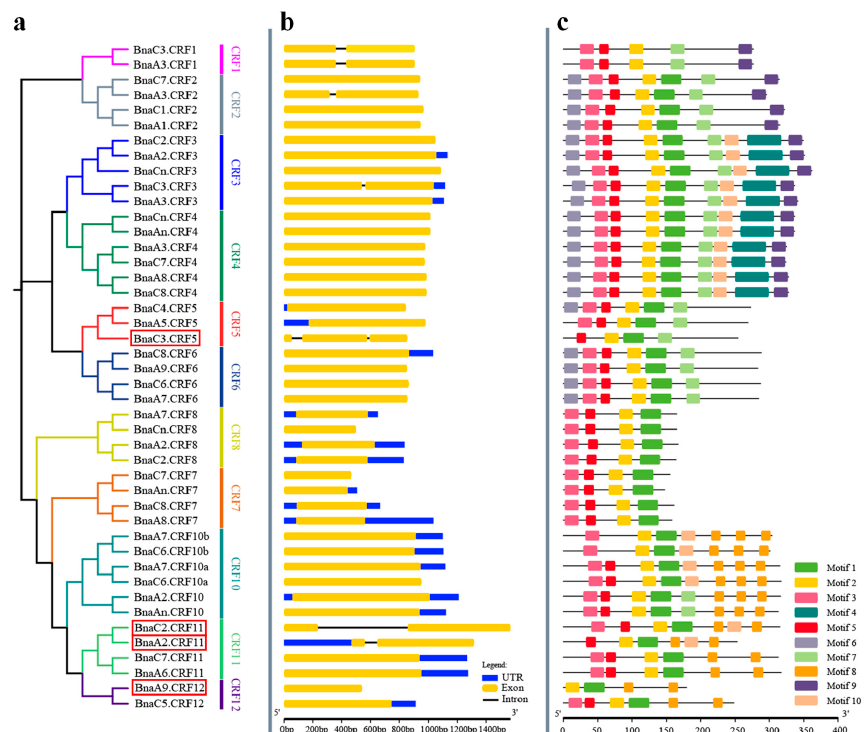
Figure 2. Phylogenetic relationships, gene structure, and architecture of conserved protein motifs in CRF genes from Brassica napus . ( a ) Phylogenetic relationships of BnaCRF genes. The phylogenetic tree (left panel) was constructed with MEGA 7.0 using the neighbor-joining (NJ) method with 1000 bootstrap replicates. Different homologous gene clusters are shown in different colors; ( b ) Gene structure of BnaCRF genes. Blue boxes indicate untranslated 5 ′ - and 3 ′ -regions; yellow boxes indicate exons; black lines indicate introns. Scale bar represents gene length; ( c ) Motif characterization of BnaCRF proteins. The motifs, number 1–10, are displayed in different colored boxes. More sequence information for each motif is provided in Figure S1. The scale bar represents the protein length. Four BnaCRF genes newly identified in this research are highlighted with a red box. Motif 3 indicates the CRF domain, while motif 2 together with motif 1 indicate the APETALA2 / ETHYLENE RESPONSIVE FACTOR (AP2 / ERF)